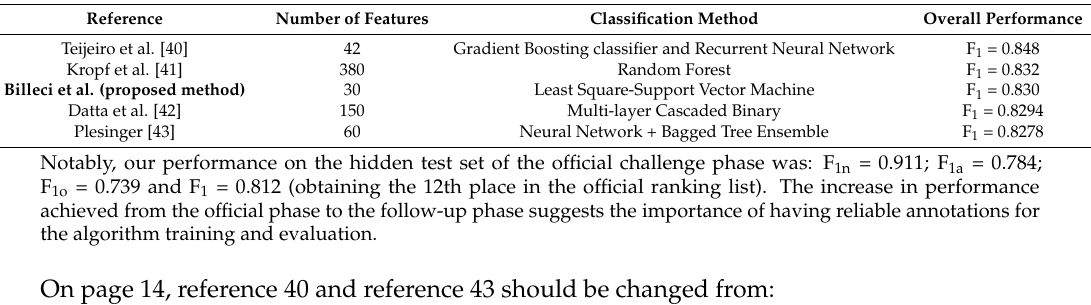
Table 3. Comparison of the results of the proposed methods with that of the other algorithms proposed for the Physionet Challenge 2017 obtained in the follow-up